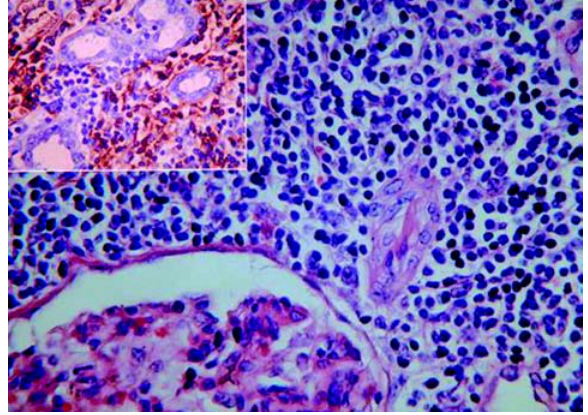
Figure 2 – Centrofollicular lymphoma, follicular grade I dif- fusely infiltrating the renal interstitium (HE). Insert: Immuno- histochemical study demonstrating the CD20 expression, char- acterizing a cell B origing